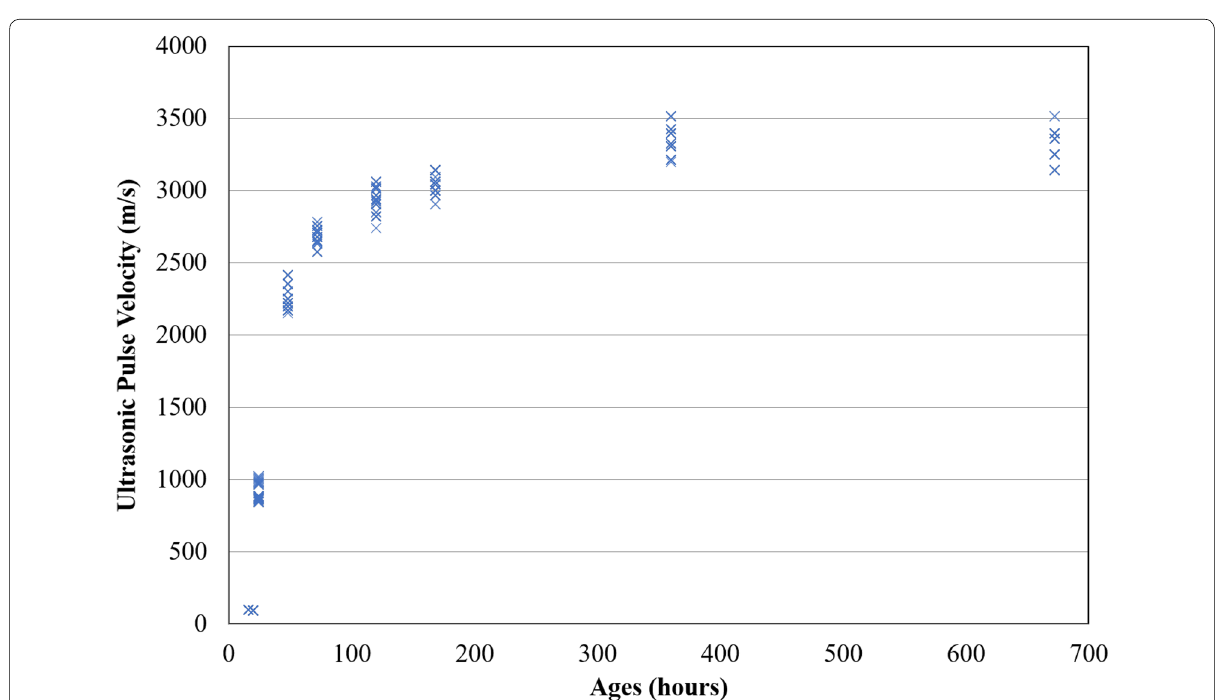
Fig. 1 Ultrasonic pulse velocity with ages (24